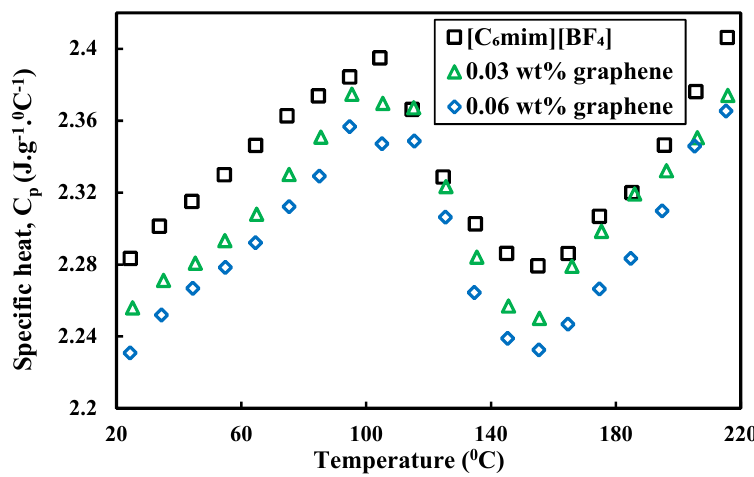
Figure 6. Specific heat of [C 6 mim][BF 4 ] and GE-dispersed IL [50]. Reproduced with permission from [Liu], [Renew. Energy]; published by [Elsevier], 2014.